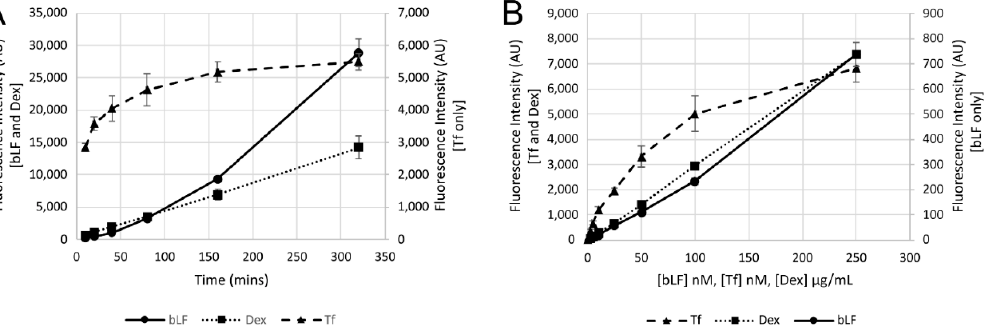
Figure 3. Kinetic analysis of the uptake of bLF647 in A549 cells. Uptake in A549 cells of bLF647, Dex647, and Tf488 analysed against time ( A ) or concentration ( B ). Cells were incubated with 250 nM bLF647, 50 µg/mL Dex647, or 20 nM Tf488 for between 10 min and 6 h; or cells were incubated with differing concentrations of bLF647, Dex647, and Tf488 for 15 min, and analysed by flow cytometry. Data represents the mean of three independent experiments with fluorescence intensity calculated as the mean from a duplicate of median cell intensity values. Error bars represent